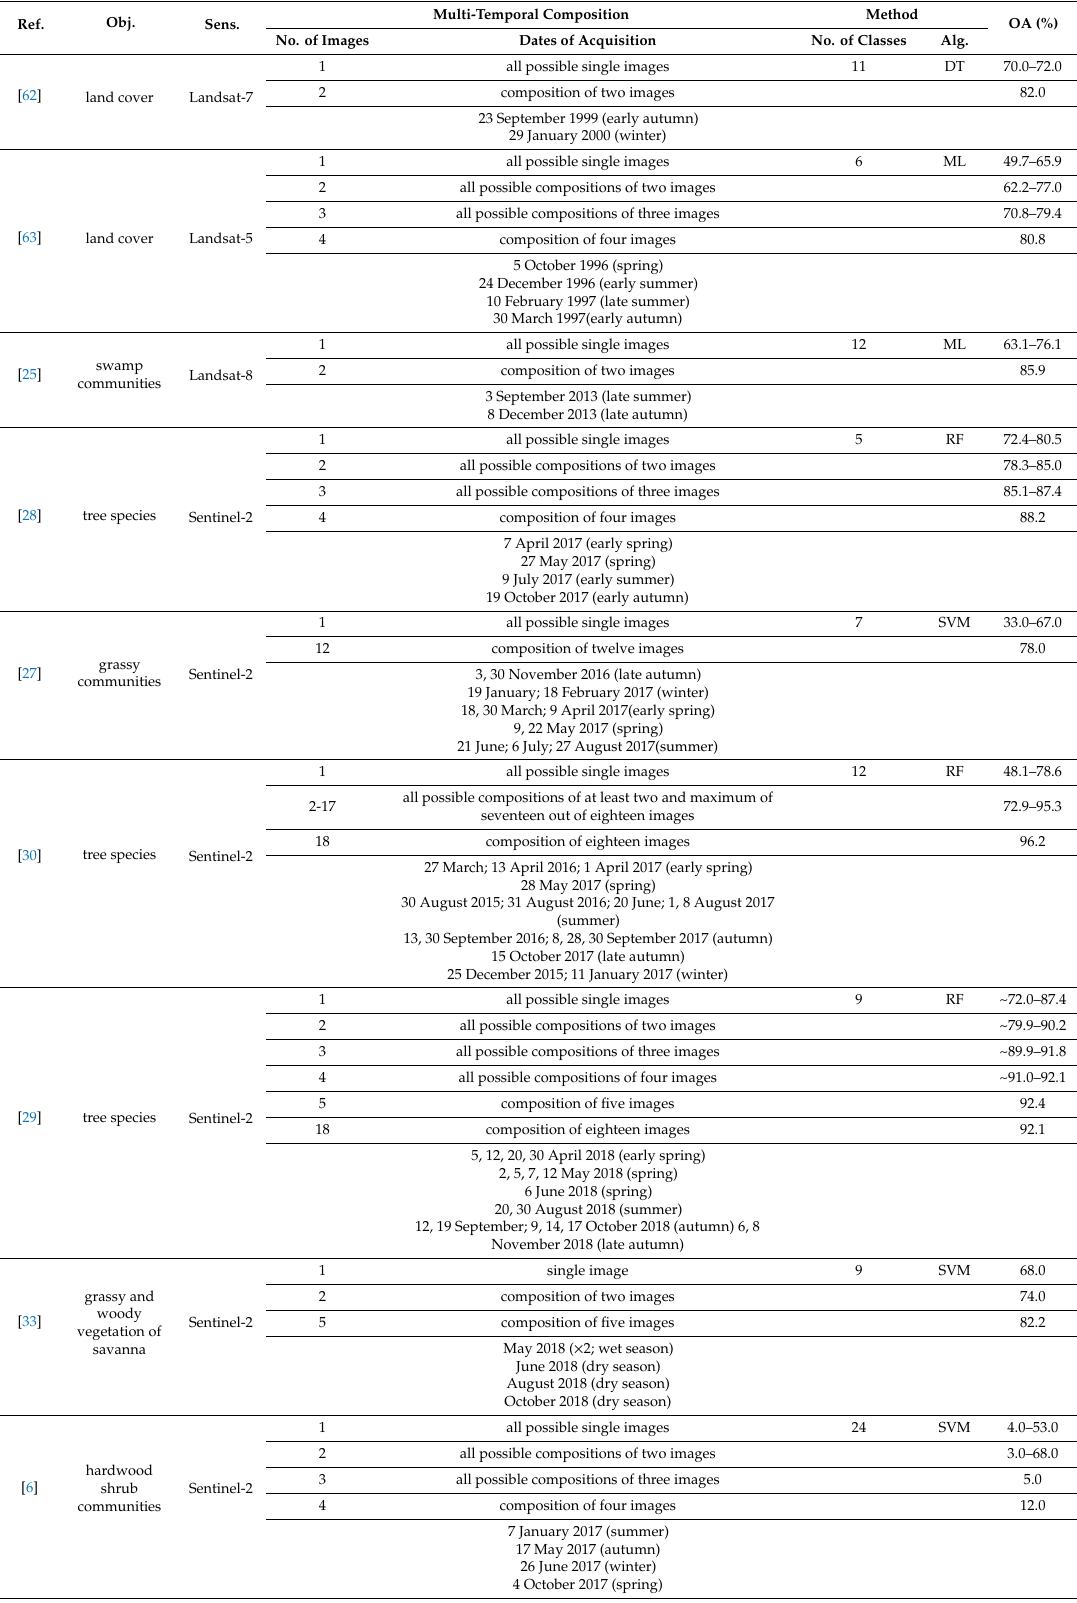
Table 5. Comparison of single-date and multi-temporal datasets usefulness for classification purposes (Ref.—reference; Obj.—object of the study; Sens.—sensor; No.—number; Alg.—algorithm; DT—decision trees; ML—Maximum Likelihood; RF—Random Forest; SVM—Support Vector Machines).